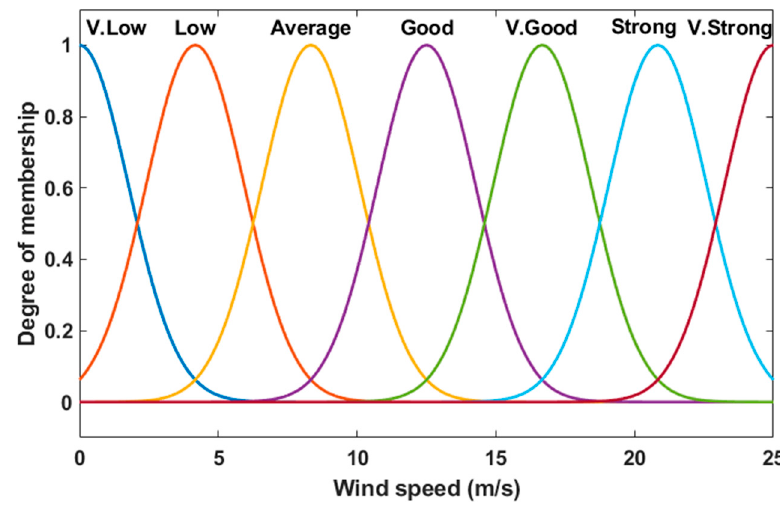
Figure 8. Nature of membership functions and number of fuzzy rules.